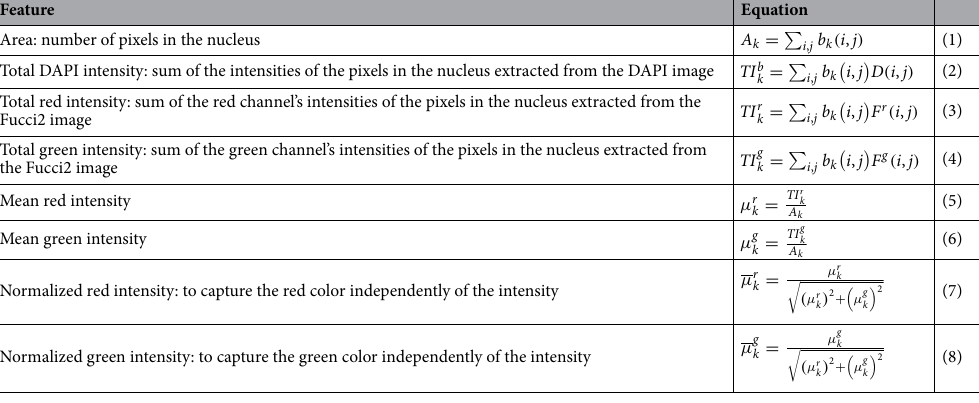
Table 1. Intensity and morphological features